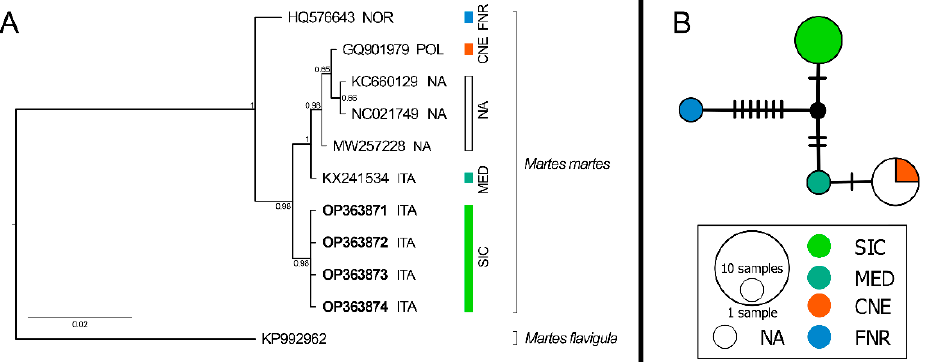
Figure 3. ( A ) Bayesian phylogram (50% majority rule consensus tree) for Martes spp. based on a 646-bp “mtDNA II” fragment. A sample of Martes flavigula was used as outgroup. Node statistical support is reported as nodal posterior probabilities. Rectangles refer to phylogroups identified by Ruiz-Gonz á lez et al. [15] (see Figure 1 for their codes), plus the novel Sicilian phylogroup (SIC). NA, Geographical origin of the samples not available. Square brackets group the samples according to the current taxonomy of the genus. Our novel sequences are reported in bold. The three-letter country codes shown in the figure are reported according to the “ISO 3166-1 alpha-3 standard”. ( B ) Median-joining haplotype network based on the “mtDNA II” dataset of Martes martes . Dashes indicate substitutions steps. Each circle represents a haplotype, and its size is proportional to its frequency. Colours refer to phylogroups shown in ( A